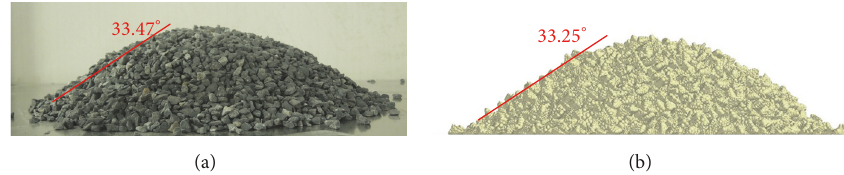
Figure 11: Experimental (a) and simulated (b) test on iron ore particles.